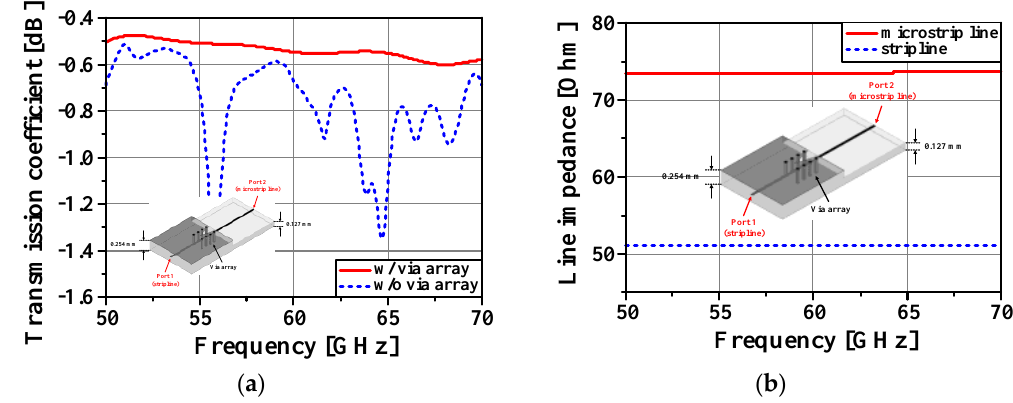
Figure 8. Simulated results of the transition part: ( a ) transmission coefficient with and without series Figure 7. Structure of the transition part. Figure 7. Structure of the transition part. Appl. Sci. 2020 , 10 , x FOR PEER REVIEW via array and ( b ) line impedance.